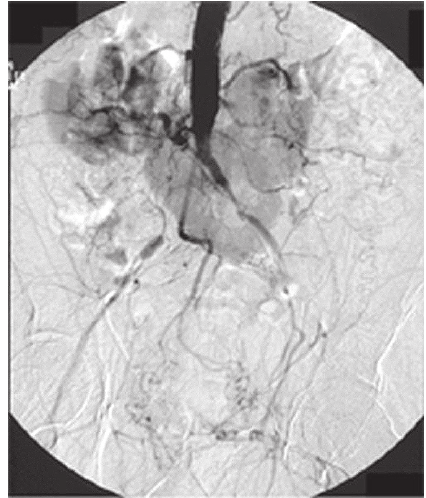
Fig. 1 -Rim em ferradura com fluxo sangüíneo específico